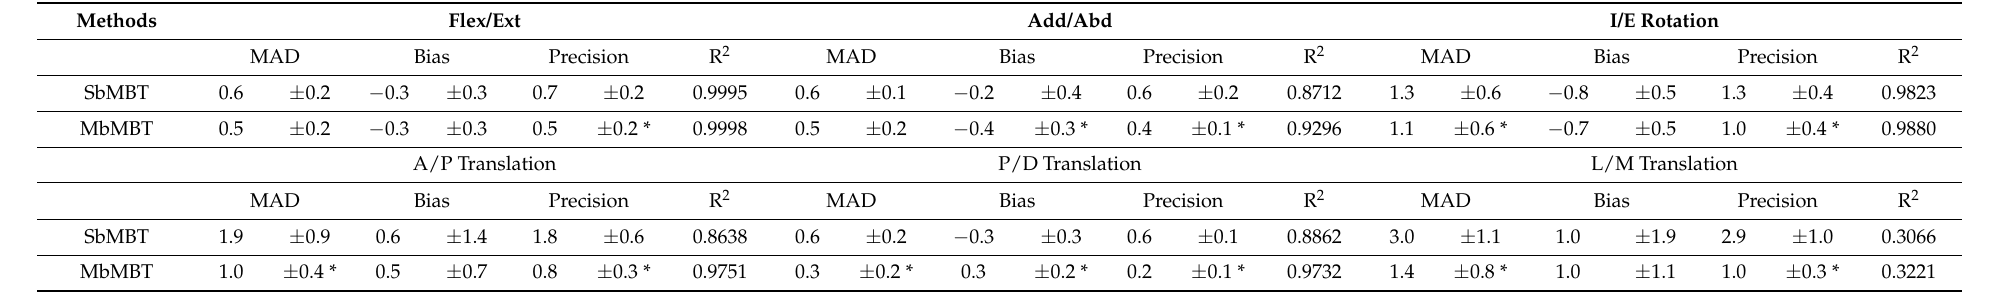
Table 3. The means ± standard deviations of the mean absolute differences (MAD), bias, and precision values over all subjects for six degree-of-freedom kinematics of the knee joint during sit-to-stand. The coefficient of determination values (R 2 ) were obtained from linear regression analysis on the knee kinematics derived from the SbMBT and MbMBT methods against the reference values. Asterisks indicate significant differences in the variables between the MbMBT and